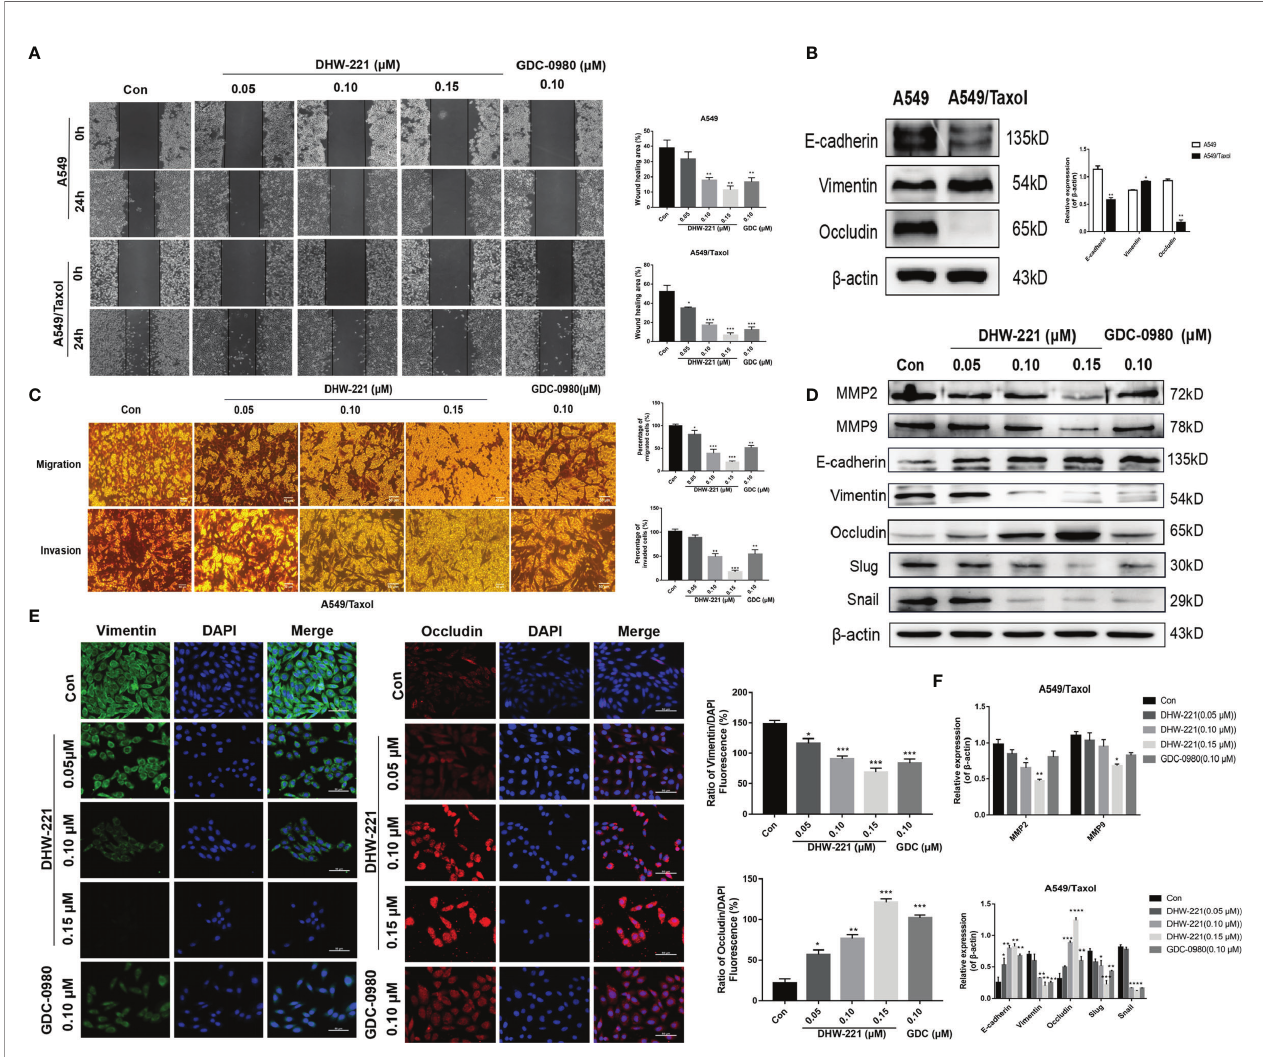
FIGURE 6 | Cell migration and invasion caused by EMT phenotype are inhibited by DHW-221 in A549/Taxol cells. (A, C) The effects of various concentrations of DHW- 221 on the migration and invasion of A549/Taxol cells were studied by the wound healing assay and Transwell assays, respectively. The corresponding quantitative statistical graphs were attached to the side. (B) The changes of EMT markers (E-cadherin, vimentin, and occludin) in A549 and A549/Taxol cells. Statistical comparisons were performed with unpaired Student ’ s t-test (n = 3). *p < 0.05, **p < 0.01 versus A549. (D, F) The expression levels and quantitative analysis results of MMP2, MMP9, and EMT markers after exposure to DHW-221 at 48 h were tested by Western blot. (E) Immuno fl uorescence staining of vimentin and occludin in A549/Taxol cells were observed by a confocal microscopy, scale bar = 100 µm. Green, red, and blue fl uorescence separately represented vimentin, occludin, and DAPI. The mean fl uorescence intensity of vimentin and occludin were measured by ImageJ, and the relative fl uorescence (green or red/DAPI ratio) were analyzed using GraphPad Prism 7.0. Statistical comparisons were carried out with one-way ANOVA followed by Dunnett ’ s post-hoc test for multiple comparisons (n = 3). Data are presented as mean ± SD. *p < 0.05, **p < 0.01, ***p < 0.001, ****p < 0.0001 versus